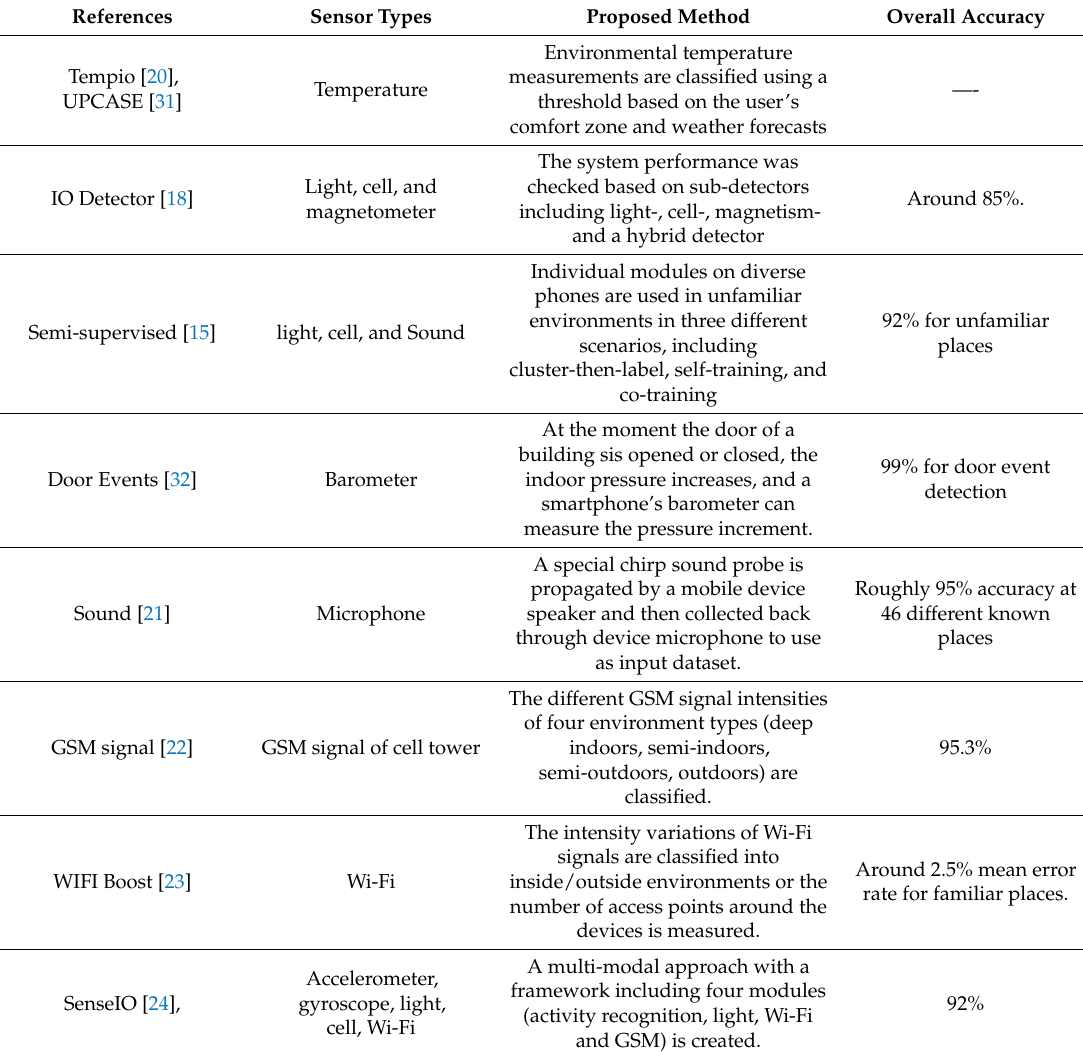
Table 1. The state-of-art for sensor-based indoor/outdoor detection